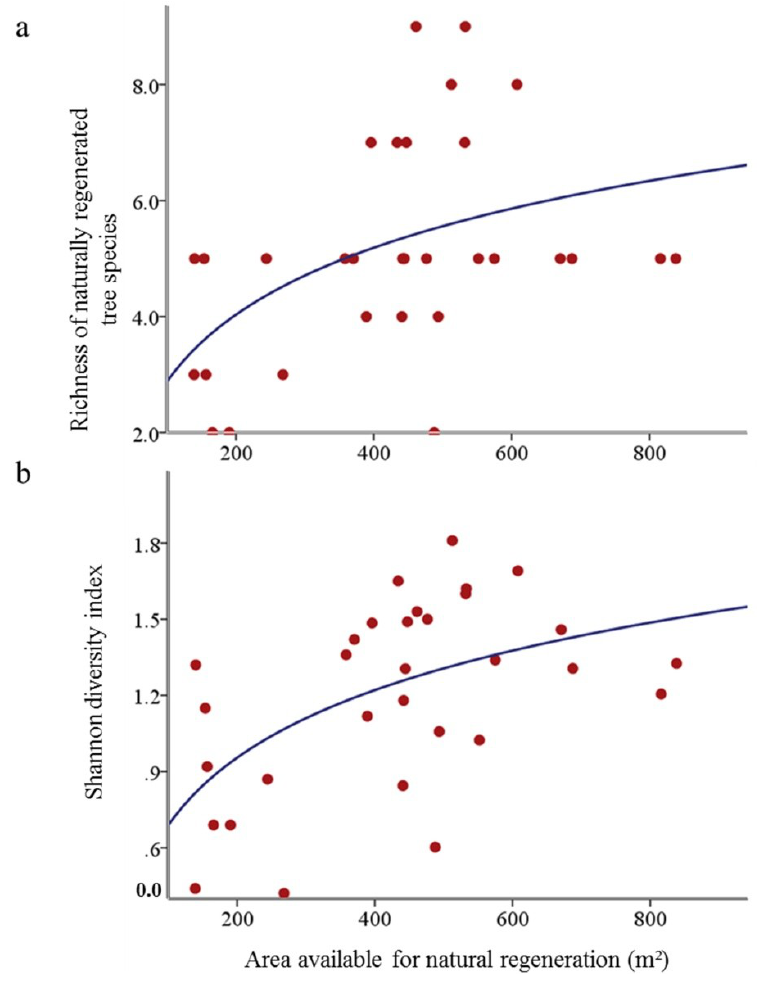
Figure 6. Area between clusters available for natural regeneration as related to ( a ) richness ( R 2 = 0.21, p < 0.05, N = 31), and ( b ) the Shannon diversity index ( R 2 = 0.29, p < 0.01, N = 31) of naturally regenerated tree